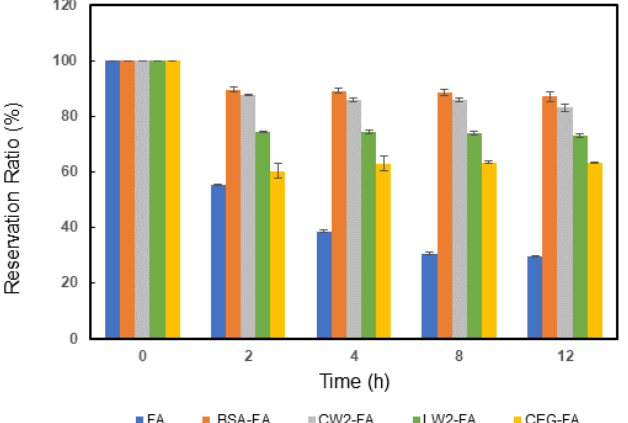
Figure 2. The time dependence of relative FA concentrations under UVA radiation. The concentra- tion of FA was 5 µg/mL in all samples. In addition to the blank control, the other groups included the 0.6 mg/mL BSA, 0.3 mg/mL CW2, 0.3 mg/mL LW2, and 0.3 mg/mL CEG groups. Error bars represent means ± SD ( n = 3).